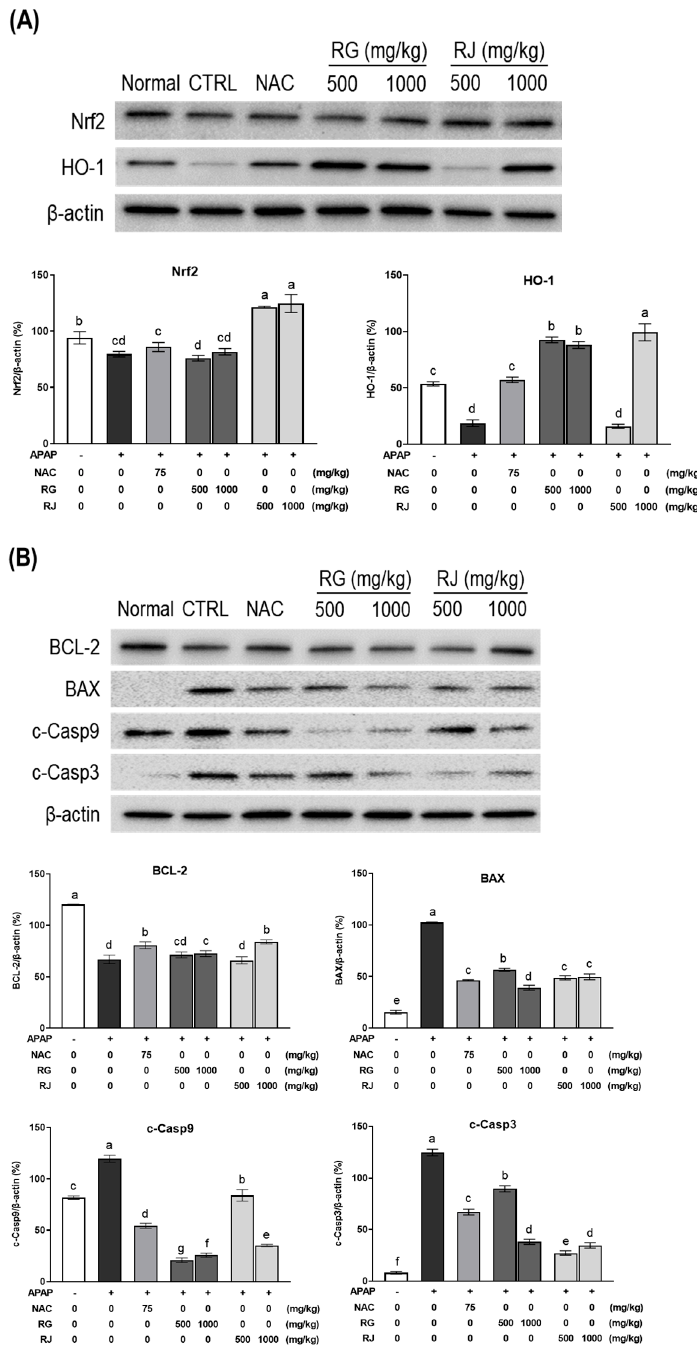
Figure 7. Effects of radish extracts on the protein expression of Nrf2/HO-1 and BCL-2/BAX pathway in APAP-induced liver-damaged mice. Expression levels of ( A ) Nrf2/HO-1 and ( B ) BCL-2/BAX pathway factors including nuclear factor erythroid 2-related factor 2 (Nrf2), heme oxygenase-1 (HO-1), B-cell lymphoma protein 2 (BCL-2), BCL-2-associated X (BAX), Caspase3 (Casp3), and Caspase9 (Casp9). Results are presented as means ± SE. Different letters represent groups that are significantly different from each other using ANOVA at p < 0.05. CTRL, control; NAC, N-acetyl cysteine; RG, turnips of Ganghwa; RJ, radishes of